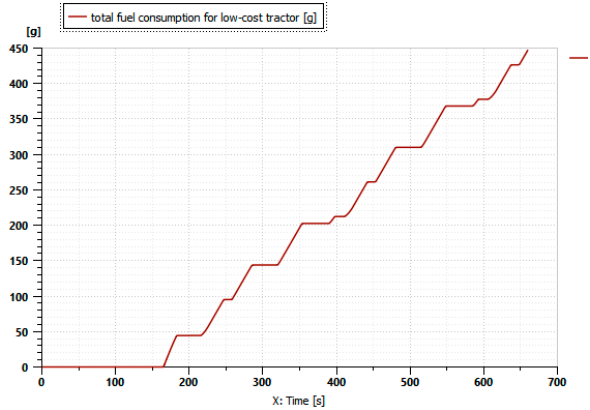
Figure 9. Fuel consumption.